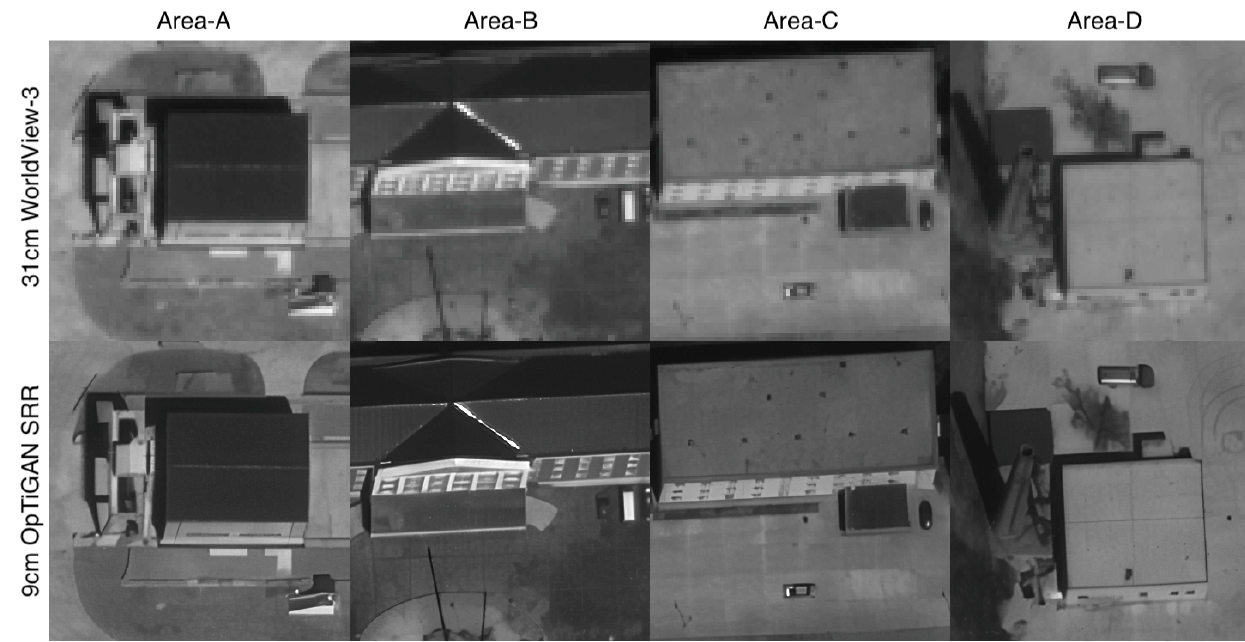
Figure 12. Examples of the 31 cm/pixel WorldView-3 image (18AUG18040034-P2AS-012860253020_01_P006) crops and the corresponding OpTiGAN SRR results showing small buildings over the Baotou site. All sub-figures have a size of 27 m by 27 m. WorldView-3 image courtesy of Maxar 2020. Data provided by the European Space Agency.